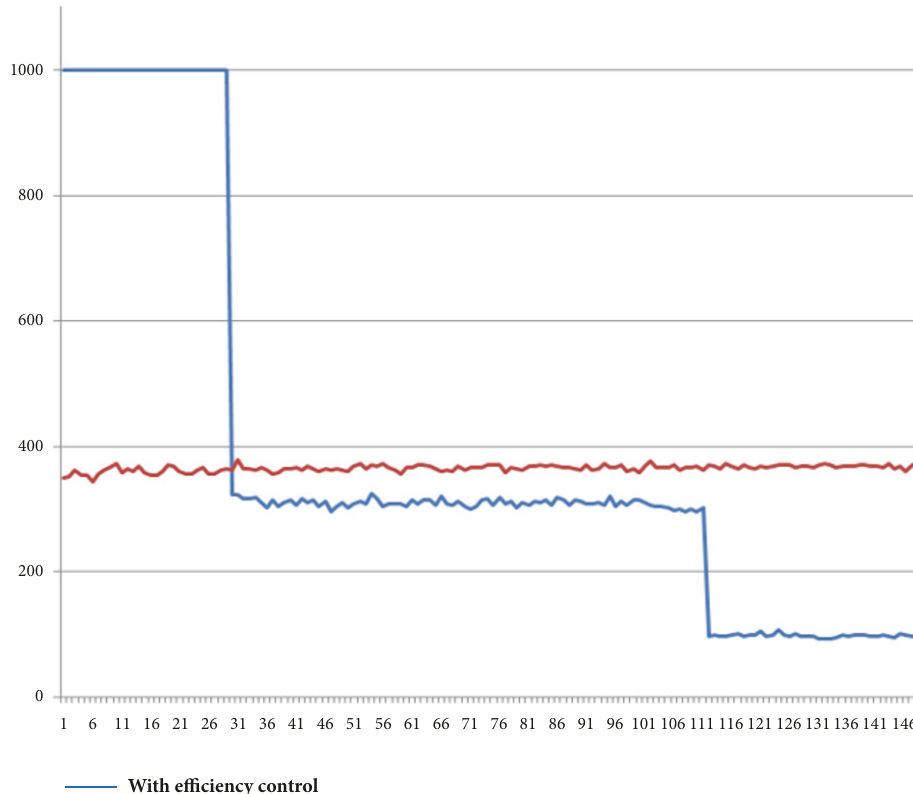
Figure 9: Efficiency curve of the first experiment.Vertical axis indicates the time cost ( ms ); the horizontal axis indicatesthe animation